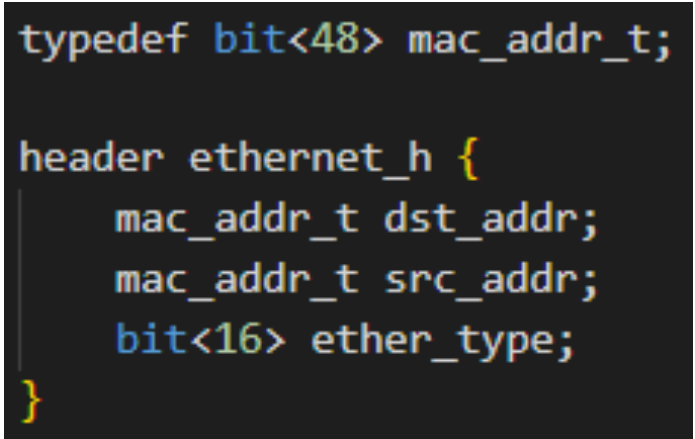
Figure A1. Example P4 Header Declaration.